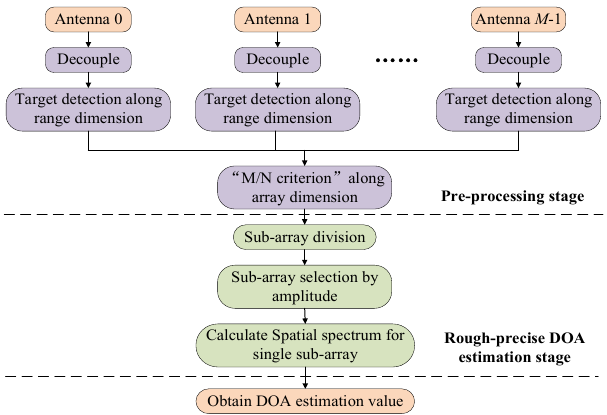
Figure 2. Two-stage fast DOA estimation algorithm flow